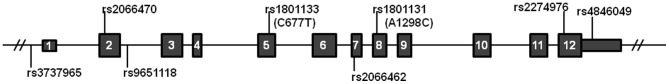
Genomic structure of the MTHFR gene and the location of the seven SNPs examined in this study.Shaded boxes represent the exons (1 to 12) of MTHFR gene and the line in between represent intron regions. Distances and locations are approximate.